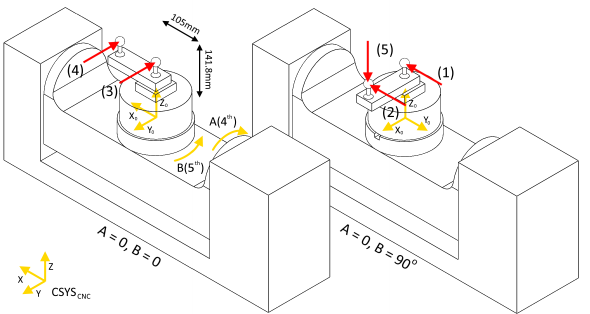
Figure 10: 2-axis trunnion: direction and placement of